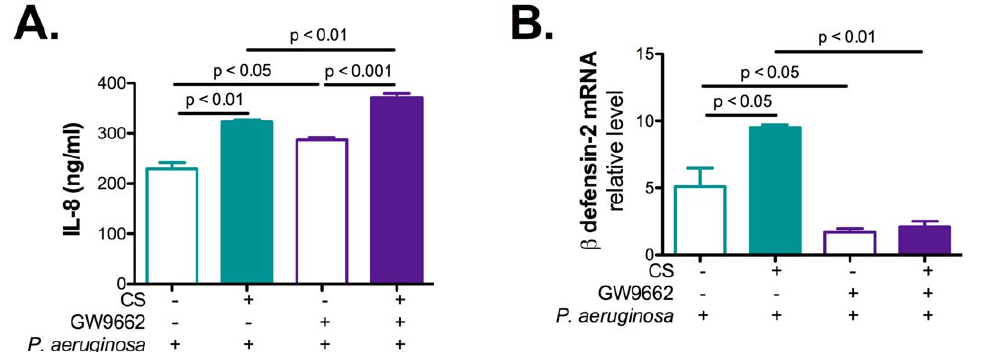
Figure 8. PPAR- c inhibition increases IL-8 secretion and decreases b -defensin 2 expression in primary NHBE cells. A. PPAR- c inhibition by GW9662 increases IL-8 secretion in the basolateral supernatant of primary NHBE cell cultures. B. FABP5 PPAR- c inhibition by GW9662 dcreases b - defensin 2 mRNA expression in primary NHBE cells. Data are representative of 3 independent experiments and are expressed as mean 6 SEM.